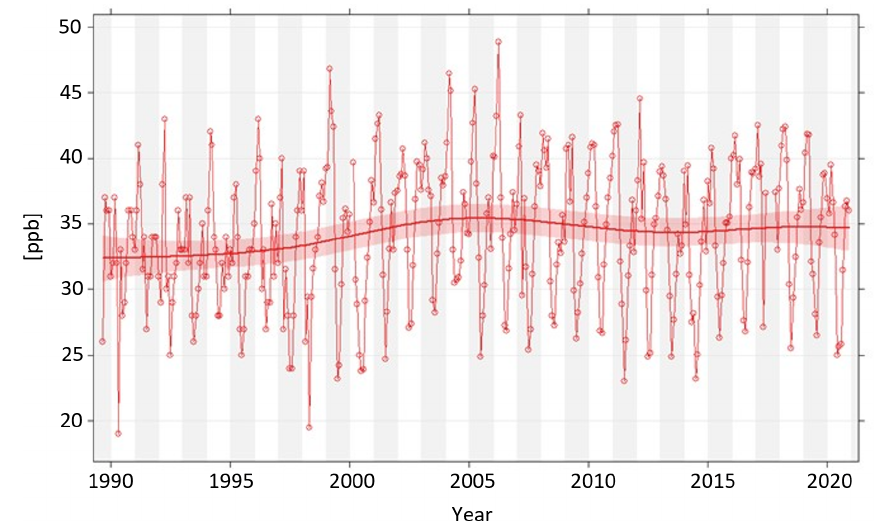
Figure 20. Monthly median concentrations of O 3 at the Zeppelin Observatory during 1989 to 2020 (ppb). Superimposed on the data is a smooth trend function (based on a generalized additive model (GAM) as provided by the smoothTrend function in the R library). Together with the trend is the 95% confidence interval shown as a